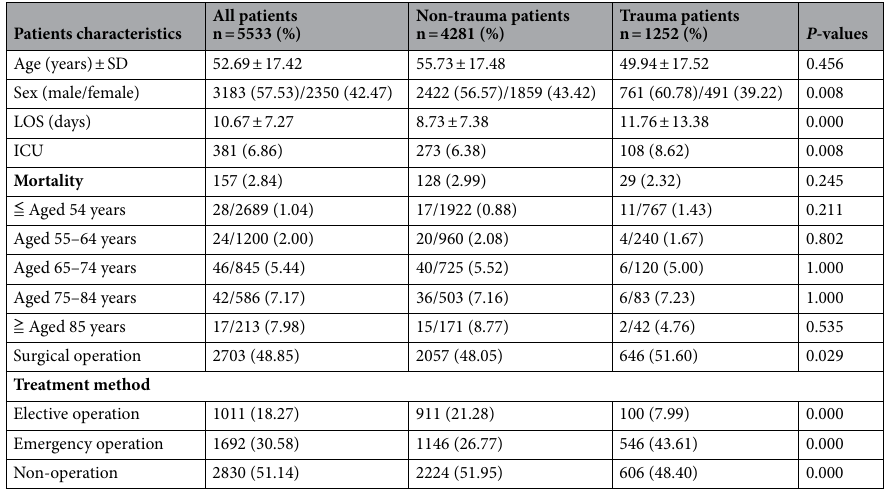
Table 1. Demographic and operative characteristics of the study population. Continuous variables are given as mean standard deviation, and categorical variables as number (percentage).